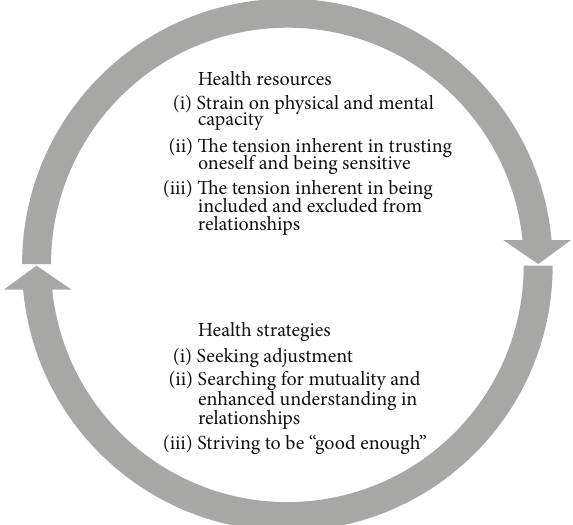
Figure 1: Overview of health resources and strategies during pregnancy and early